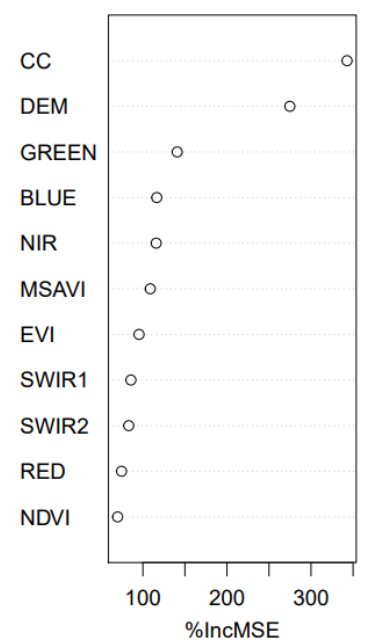
Figure 2. Scatter plot of observed and estimated canopy height at 30 m spatial resolution from the independent validation for ( a ) random forest and ( b ) regression kriging.